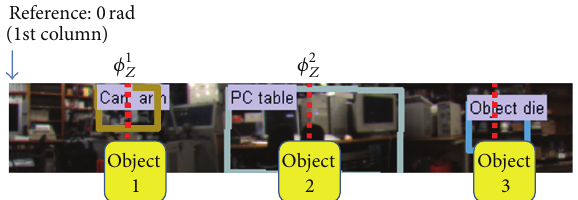
Figure 11: Bearing measurement information of recognized objects in panoramic